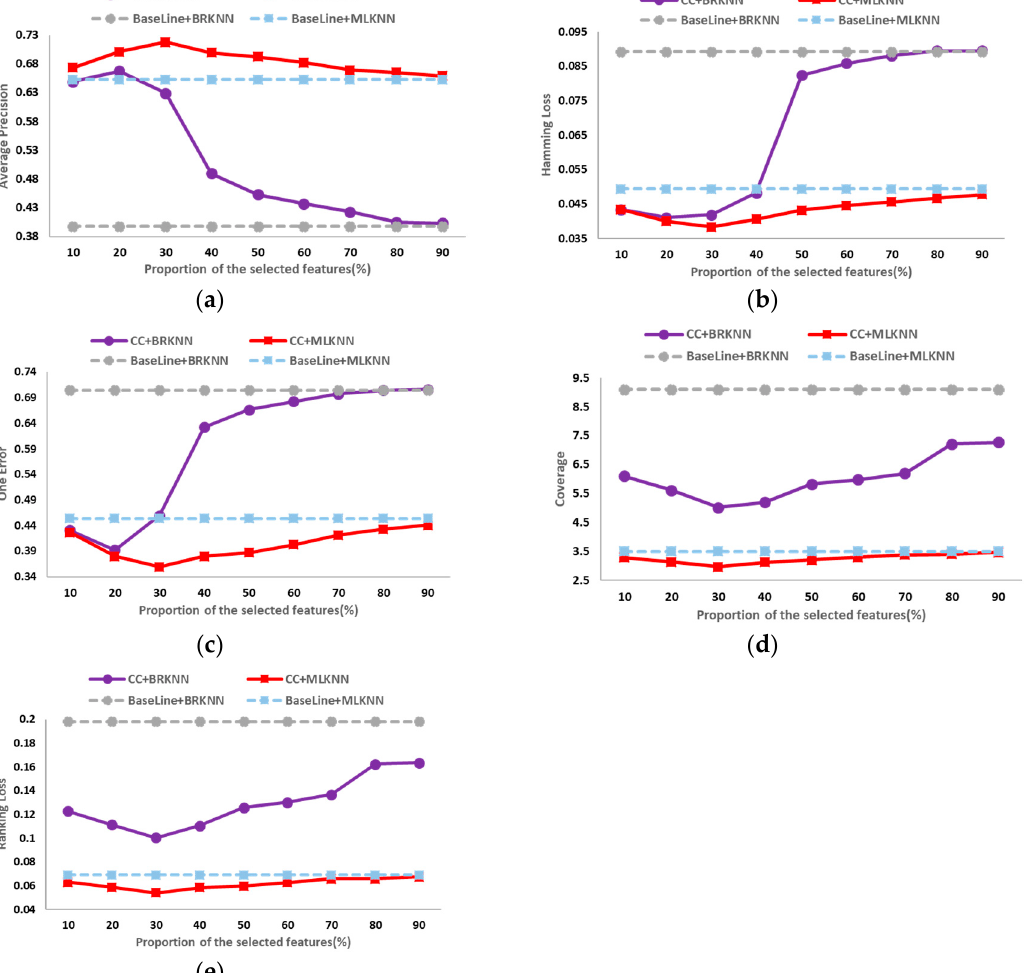
Figure 5. Experimental results on Entertainment data set. ( a ) Average Precision; ( b ) Hamming Loss; ( c ) One Error; ( d ) Coverage; ( e ) Ranking Loss.